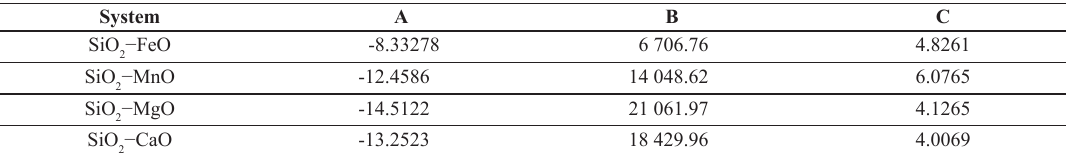
Table 2. Values of model parameters for different binary silicate systems.